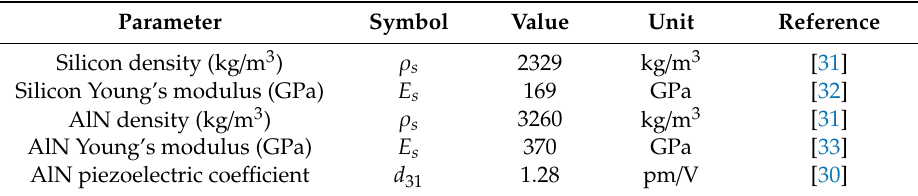
Figure 1. Schematic diagram of the device design. A bridge structure of length L and width W consisting of a silicon substrate with thickness 𝑡 𝑠 , covered by an AlN piezoelectric layer of thickness tp. Two symmetrically disposed metallic electrodes were placed closed to the edges, starting at a distance 𝑙 1 and ending at a distance 𝑙 2 . Table 2. Electromechanical properties used in the analysis.